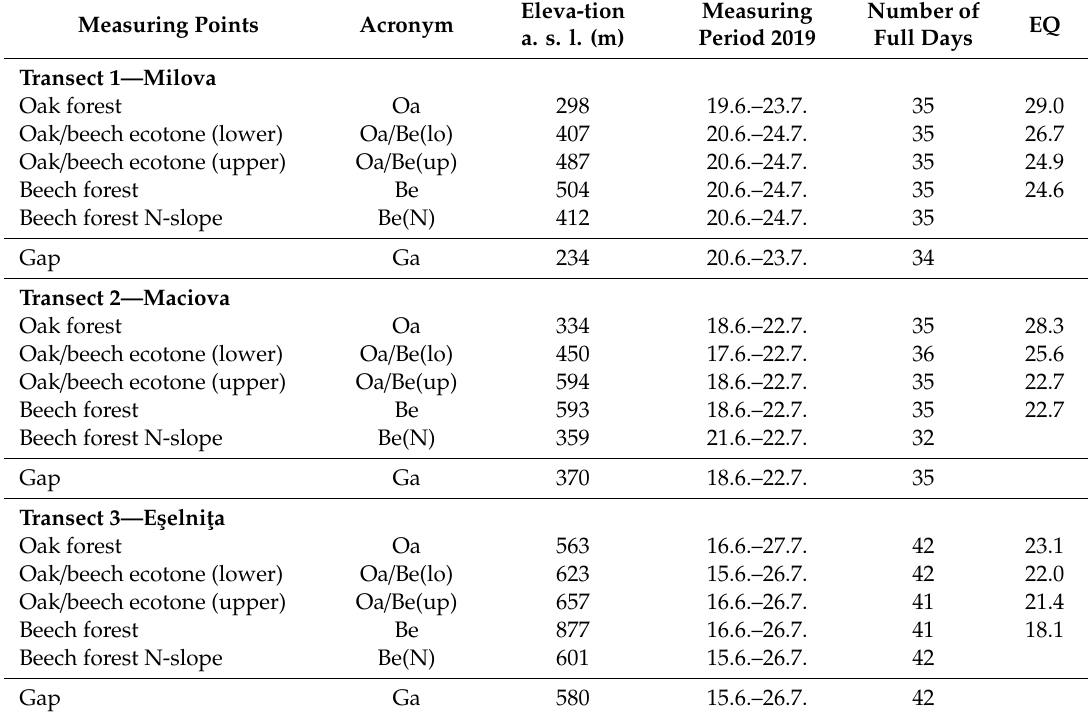
Table 2. Location of the five measuring points in the three transects and in the forest gaps with forest type, acronym, elevation, length of measuring periods (full day: 0:00–23:45), and the Ellenberg